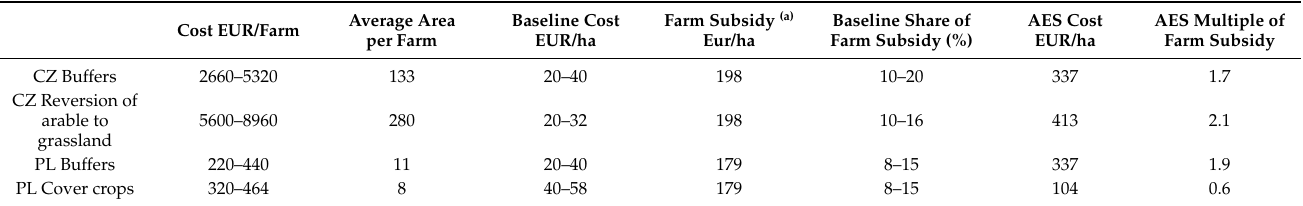
Figure 3. Temporal unfolding of the agri-environment budget in the 2000–2012 time frame in comparison with CAP subsidies. Table 5. Cost effectiveness of AES in two member